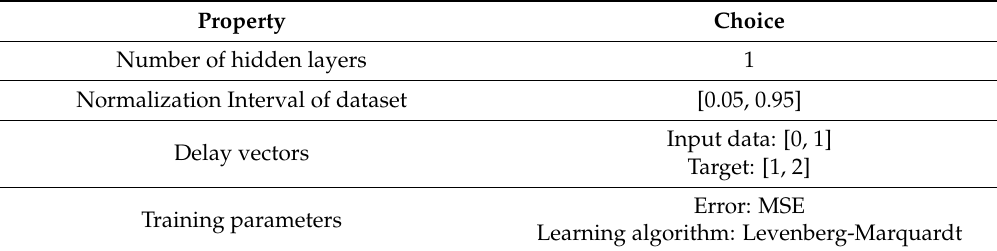
Table 4. Parameters of the NARX model